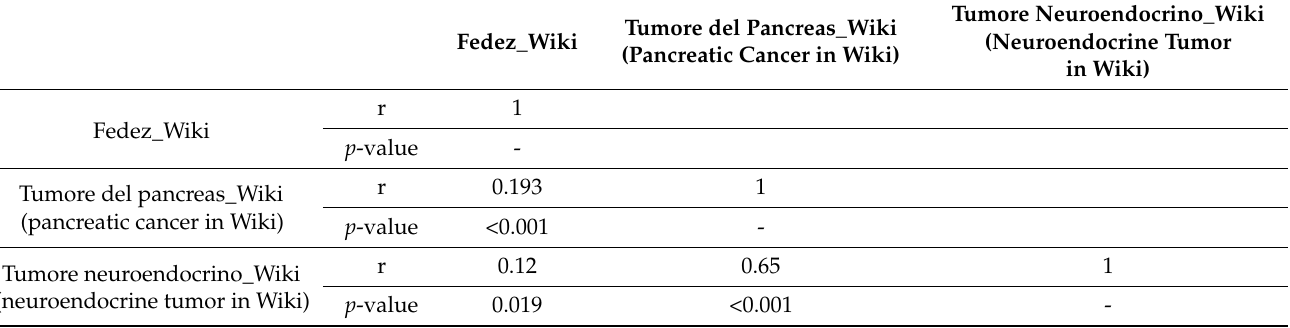
Table 4. Pearson’s correlation coefficient (r) for Wikipedia searches in Italy from 1 October 2021 to 31 October